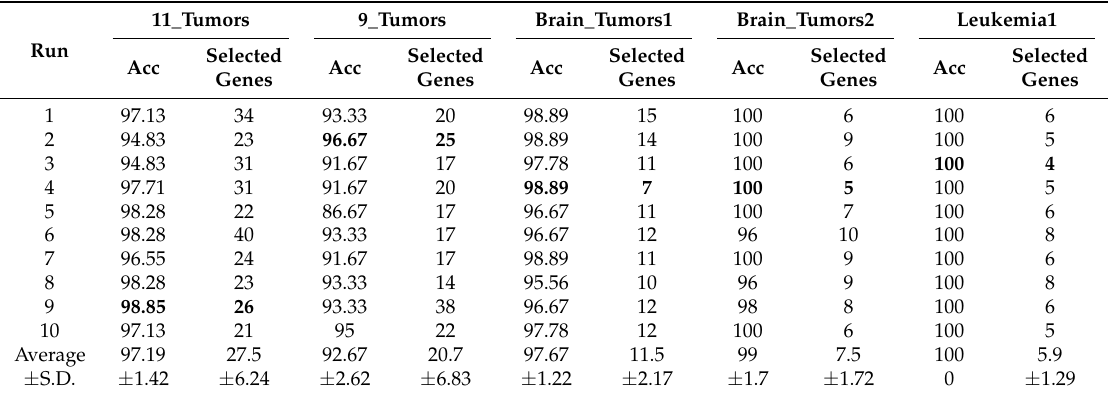
Table 3. Experimental results for each run using multiobjective binary differential evolution (MOBDE) on 11_Tumors, 9_Tumors, Brain_Tumors1, Brain_Tumors2 and Leukemia1.